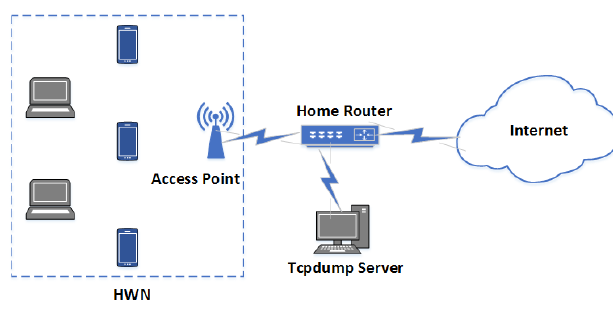
Figure 4. Home Wireless Network (HWN) for normal traffic